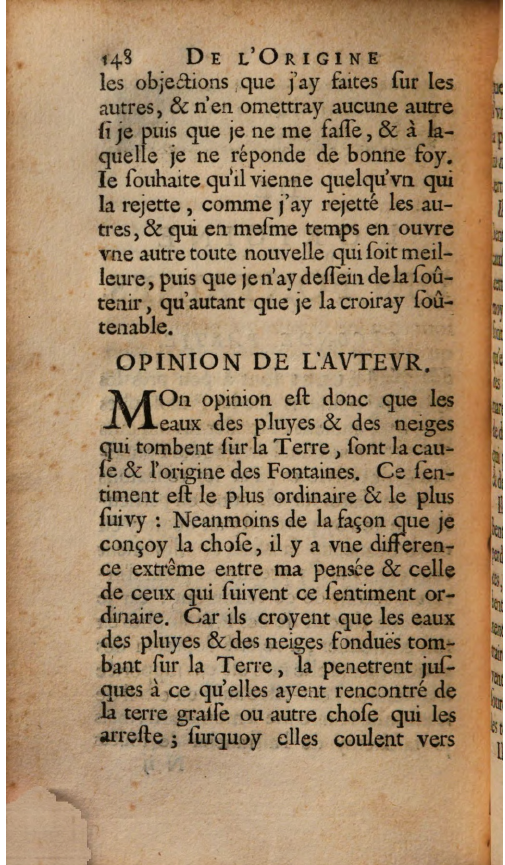
Figure 3. Statement of Perrault’s opinion (Perrault, 1674, p. 148, credits: Bayerische Staatsbibliothek München, Rar. 4600,